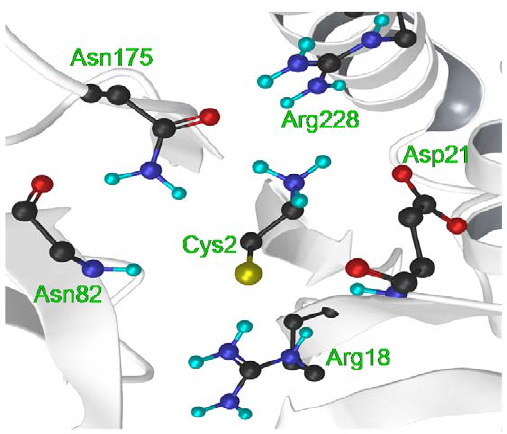
Figure 2. CBAH residues interacting with Cys2 as found in the crystal structure. Secondary structure elements of CBAH are displayed with gray cartoons, while carbon atoms are in black.